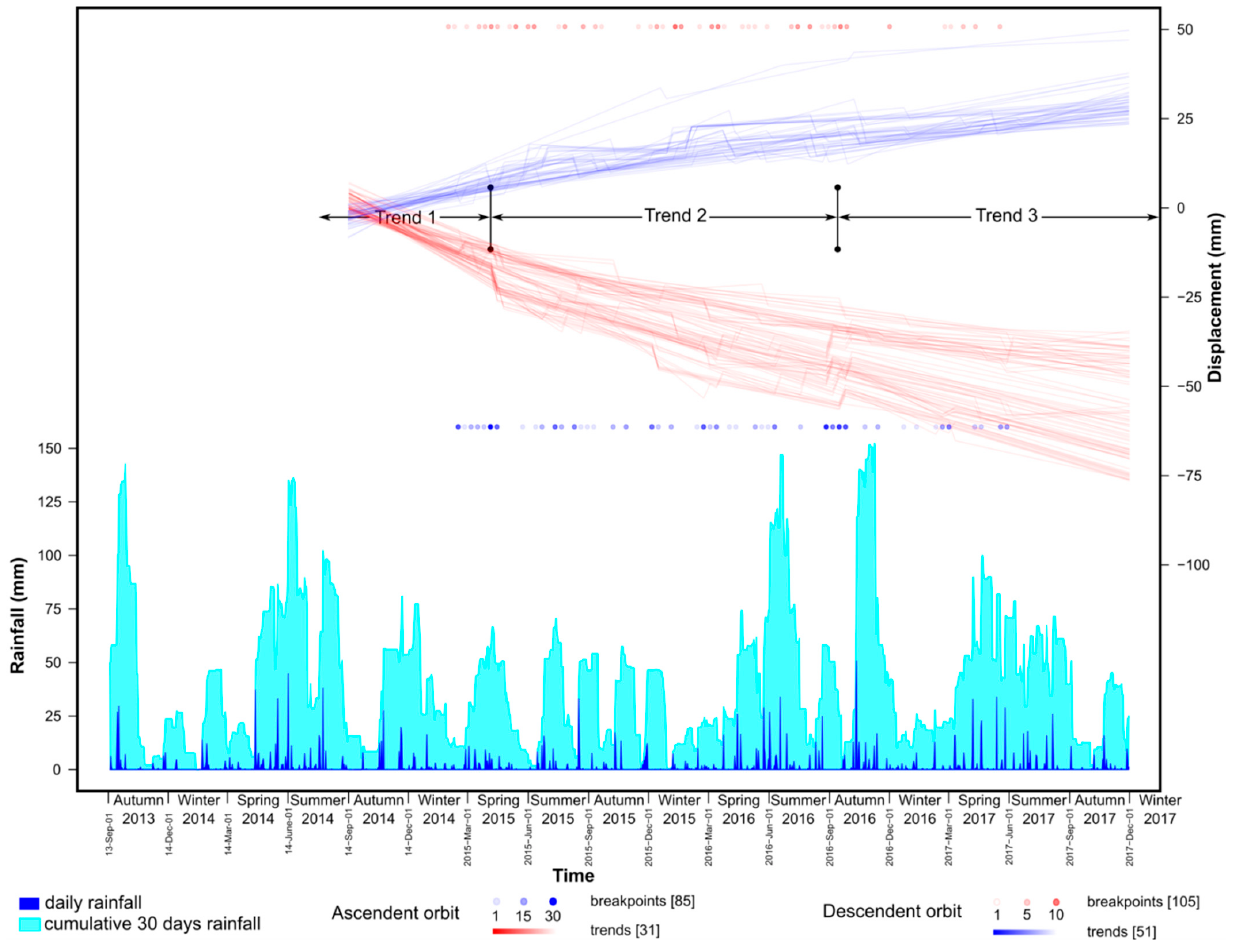
Figure 9. Displacement time series trend of representative PS measurements for Ț ic ă u landslide and the rainfall time , Scheme 0. while for the descending orbit, PSs bigger than 0.2. The trend is derived with the methodology presented in Section 3.2, and the trend lines have 10% transparency. The trend breakpoints are plotted as points rug plots with 10% transparency. (high-resolution image available at https://doi.org/10.6084/m9.figshare.14920113.v1).